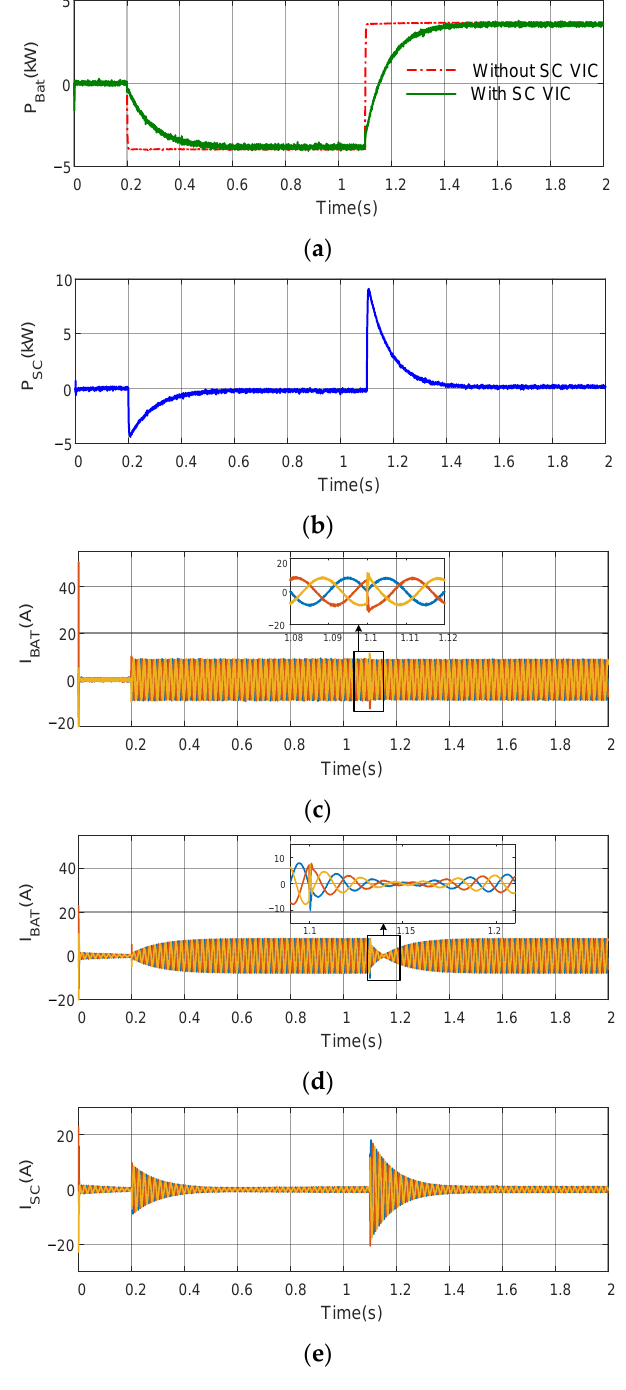
Figure 12. The virtual inertia responses of the battery and SC. ( a ) Comparison of battery output power with and without VIC; ( b ) SC output power profile; ( c ) battery converter output current waveform without SC VIC; ( d ) battery converter output current waveform with SC VIC strategy; ( e ) SC converter output current waveform with VIC strategy.